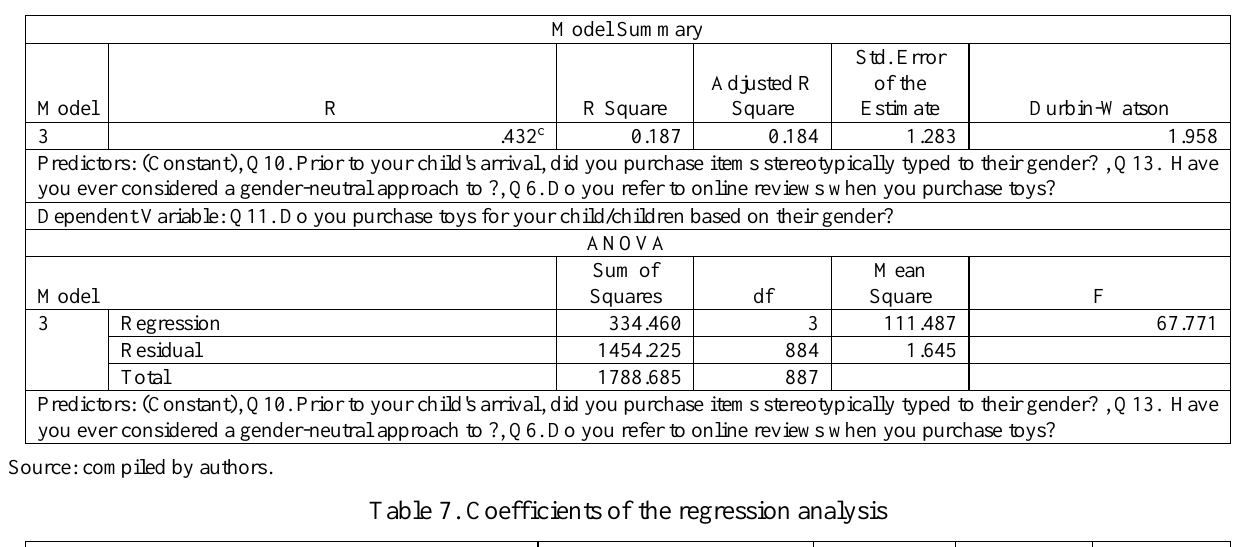
Table 6. Regression results obtained from analysis of variance